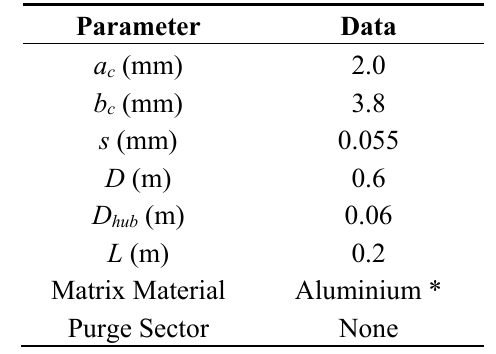
Table 1. Main data of tested heat wheel.